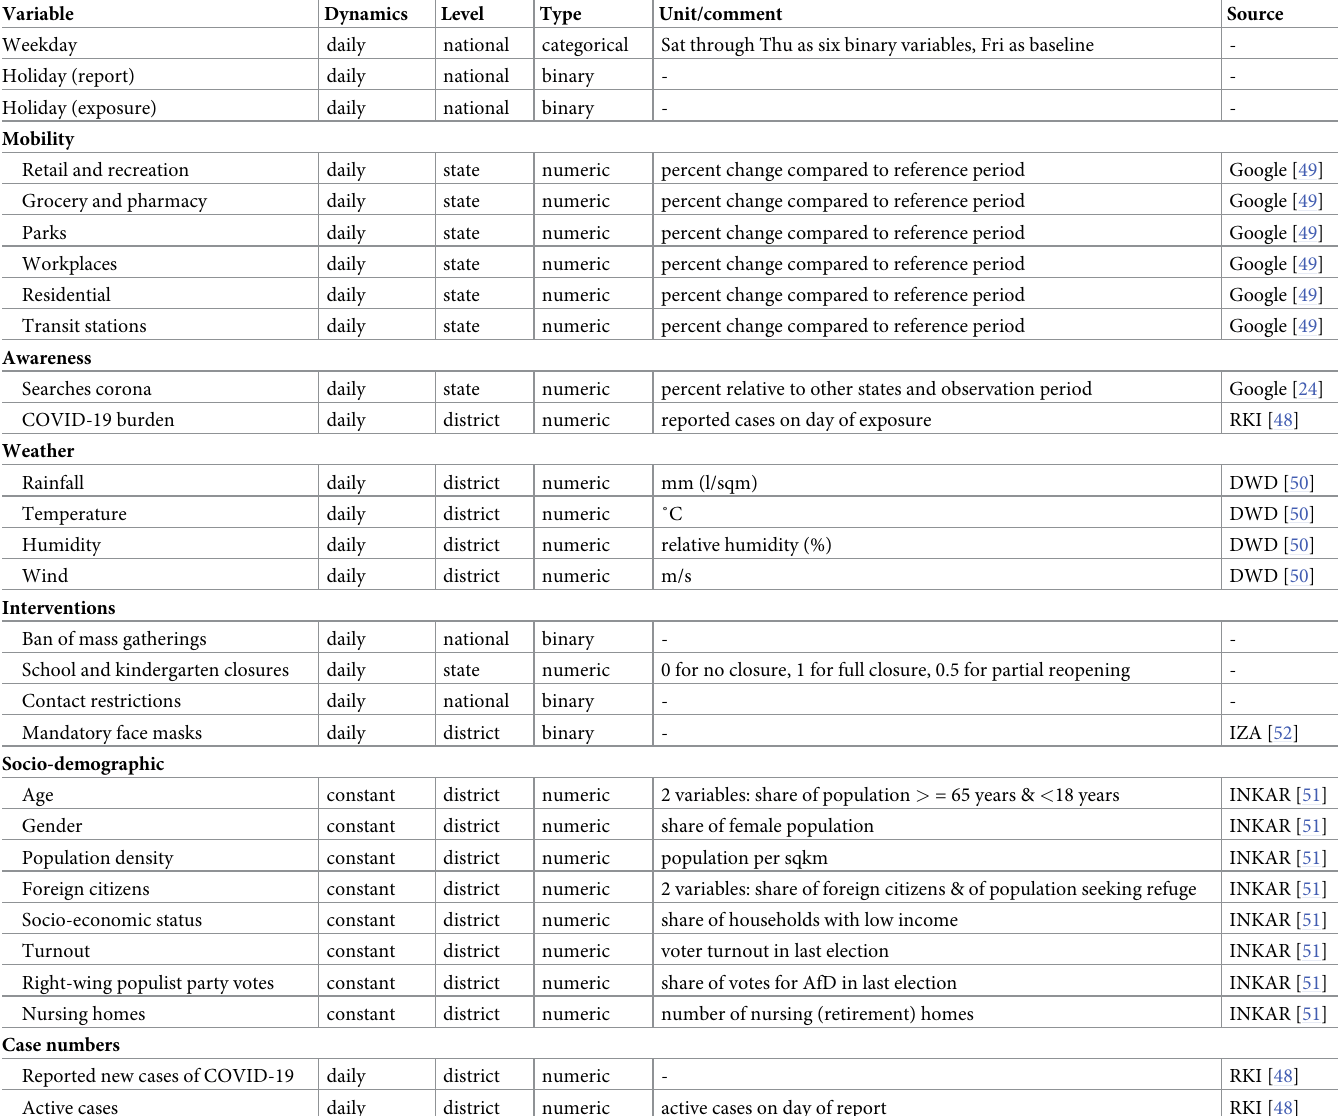
Table 1. Observed model